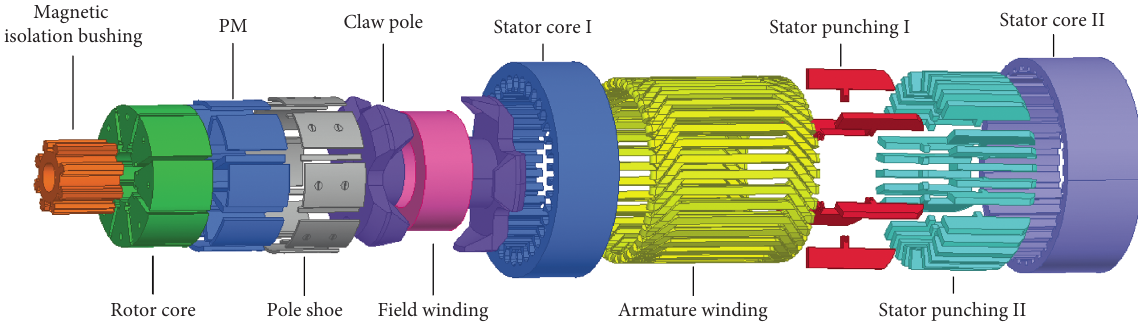
Figure 1: The structure of the proposed PMCHEG. Table 1: Main technical indexes of the proposed